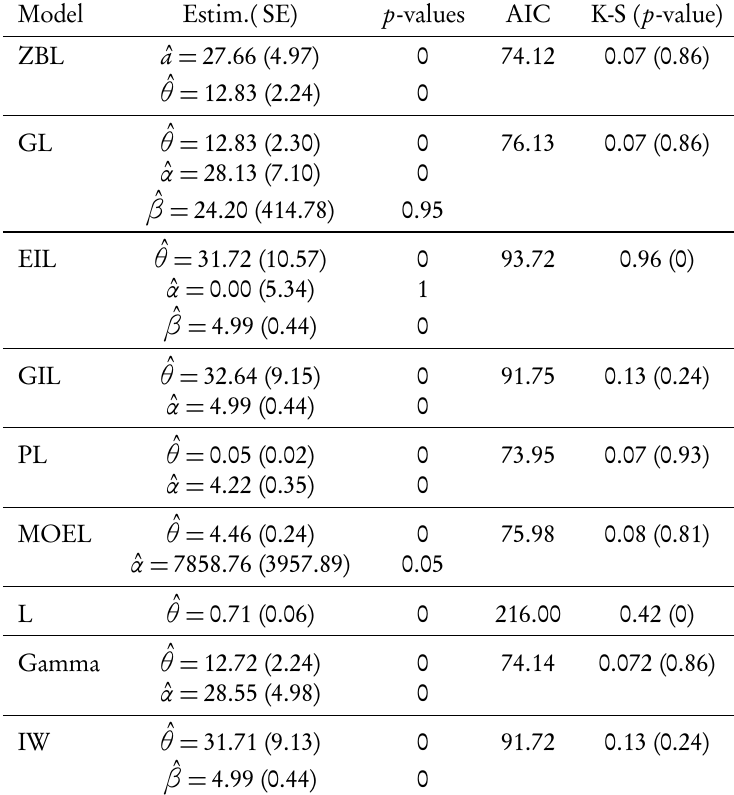
The estimated parameters, the corresponding standard errors, and the goodness-of-fit statistic for the models fitted to the the failure stresses of single carbon fibers